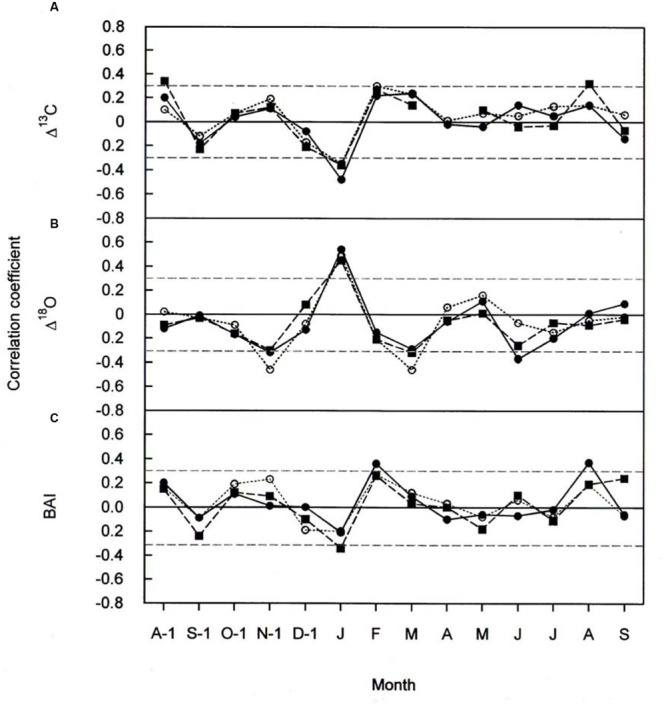
Pearson correlation coefficients between (A)Δ13C(B)Δ18O, and (C) BAI, and monthly total precipitation for P. cembra (solid circle, solid line), P. abies (solid square, dashed line) and L. decidua (open circle, dotted line) between 1975 and 2010. Horizontal gray lines indicates P < 0.05.